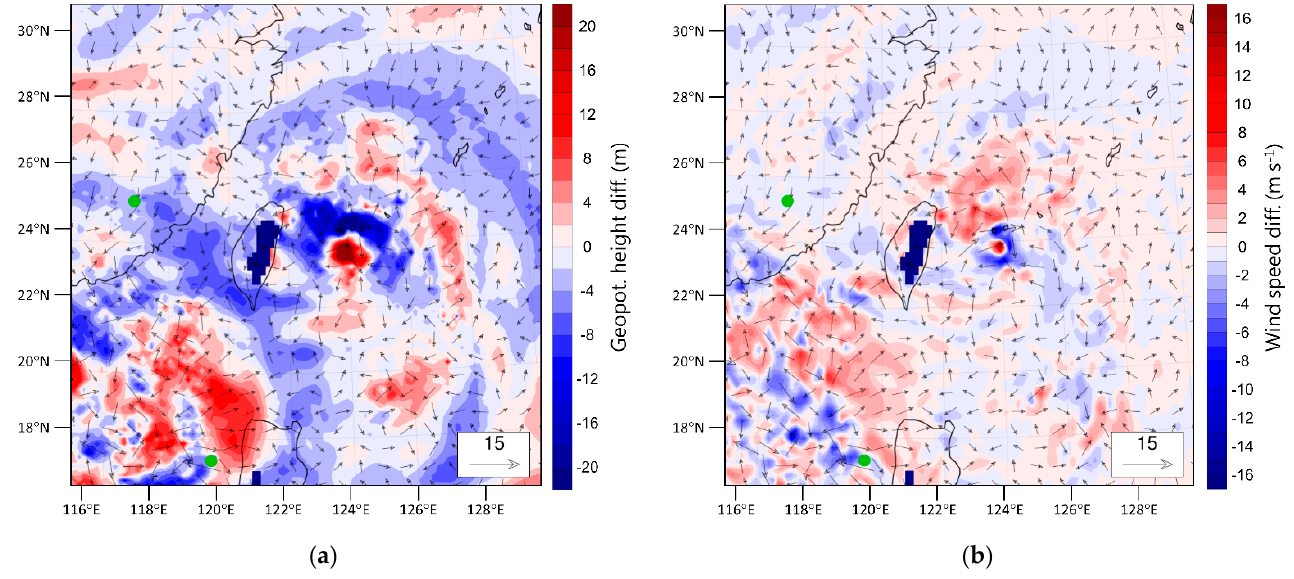
Figure 15. The 850-hPa ( a ) geopotential height difference and ( b ) wind speed difference of WRF Member 2 minus WRF Member 1 at 24 h for the forecast sample initialized at 12:00 UTC 1 August 2020. The arrows indicate the wind difference. The green dots denote the COSMIC-2/FORMOSAT-7 RO observations assimilated by WRF Member 2. The dark blue shading indicates terrain.